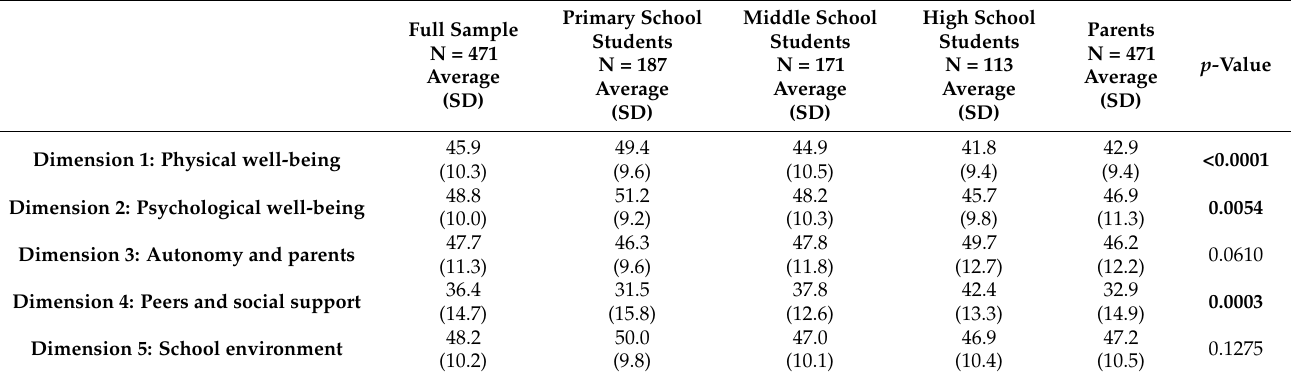
Table 4. Children’s quality of life scores assessed by themselves and by their parents.